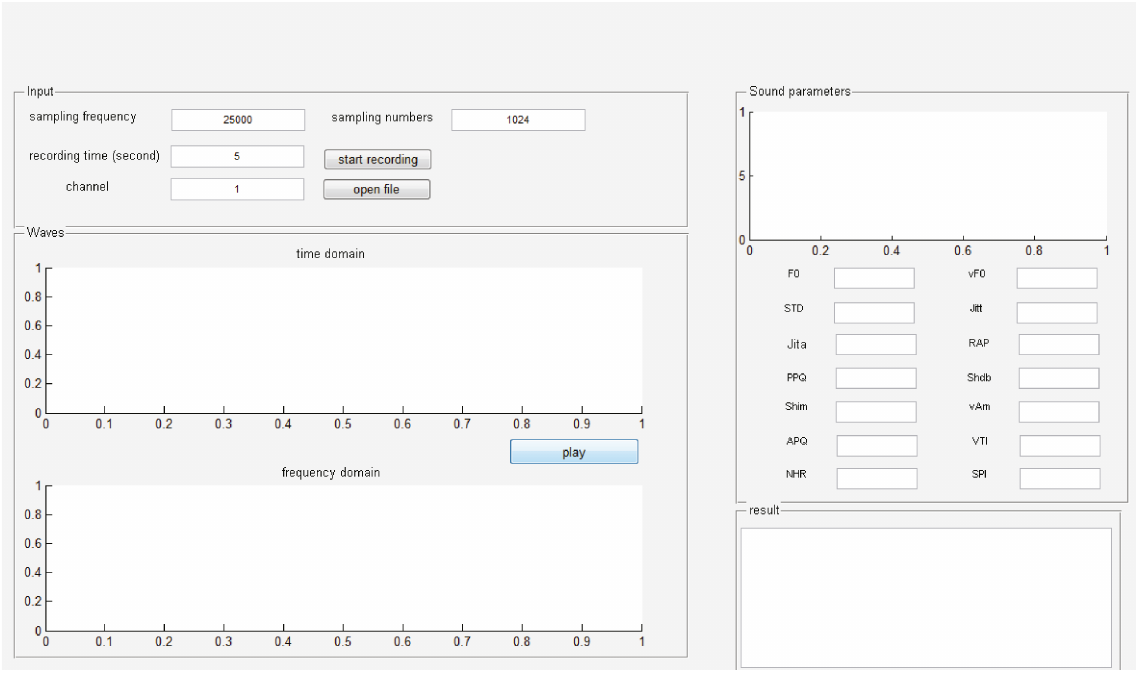
Figure 14: Pathological voice source analysis